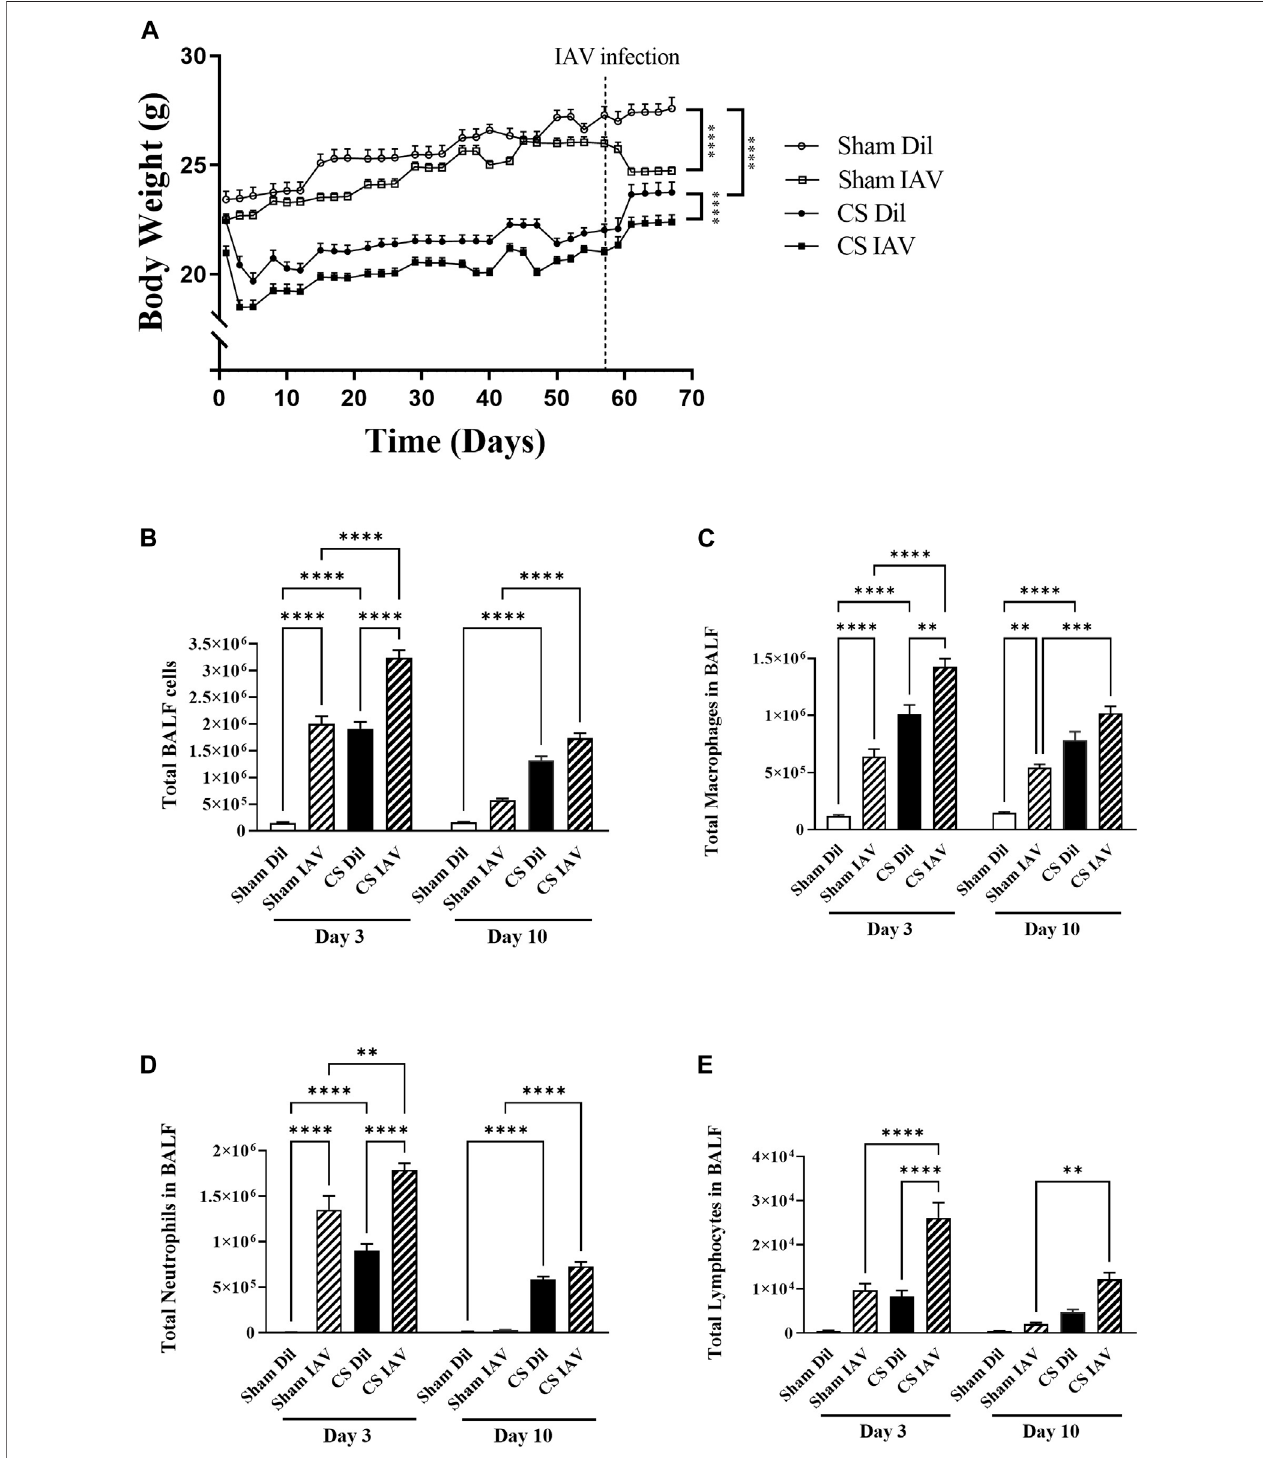
FIGURE 1 | Effect of CS exposure and in fl uenza A virus (IAV) infection on body weight and BALF cellularity. (A) Progressive body weight of mice across the experiment, and number of (B) total cells, (C) macrophages, (D) neutrophils and (E) lymphocytes in the bronchoalveolar lavage fl uid in CS-exposed and Sham mice following IAV infection. Data shown as mean +SEM ( n = 7 per group). ** p < 0.01, *** p < 0.001, **** p < 0.0001.